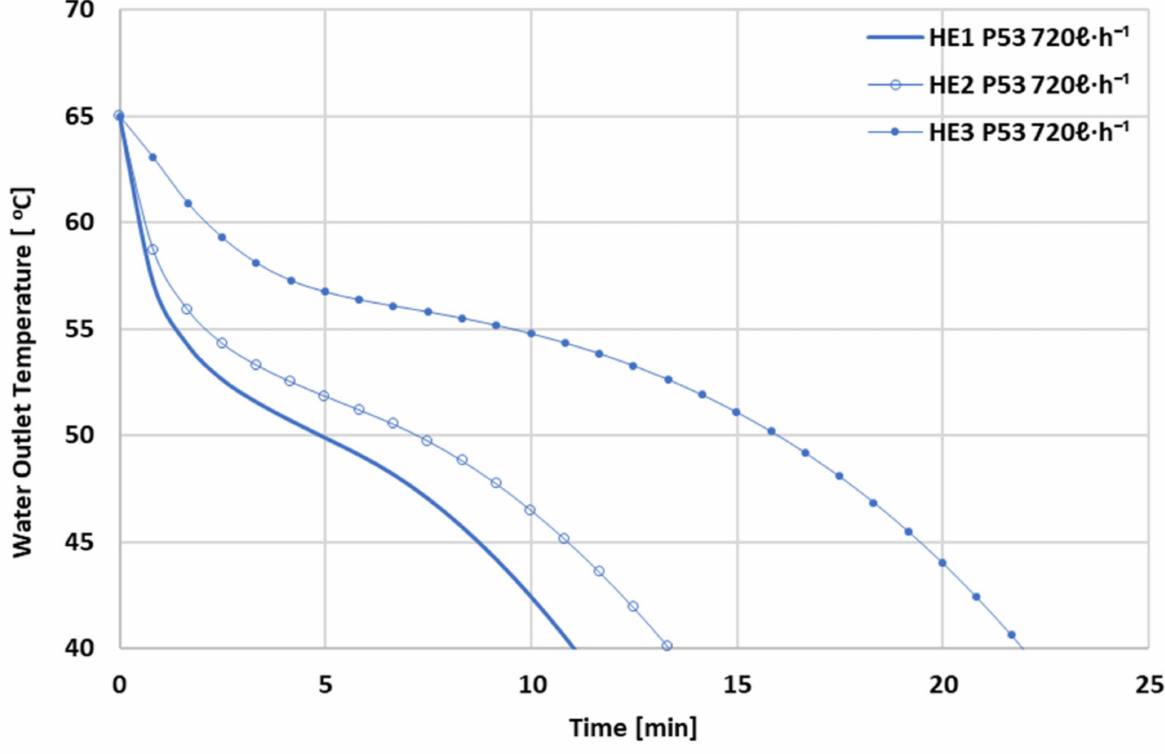
Figure 14. Water outlet temperature versus time for all HEs studied, for